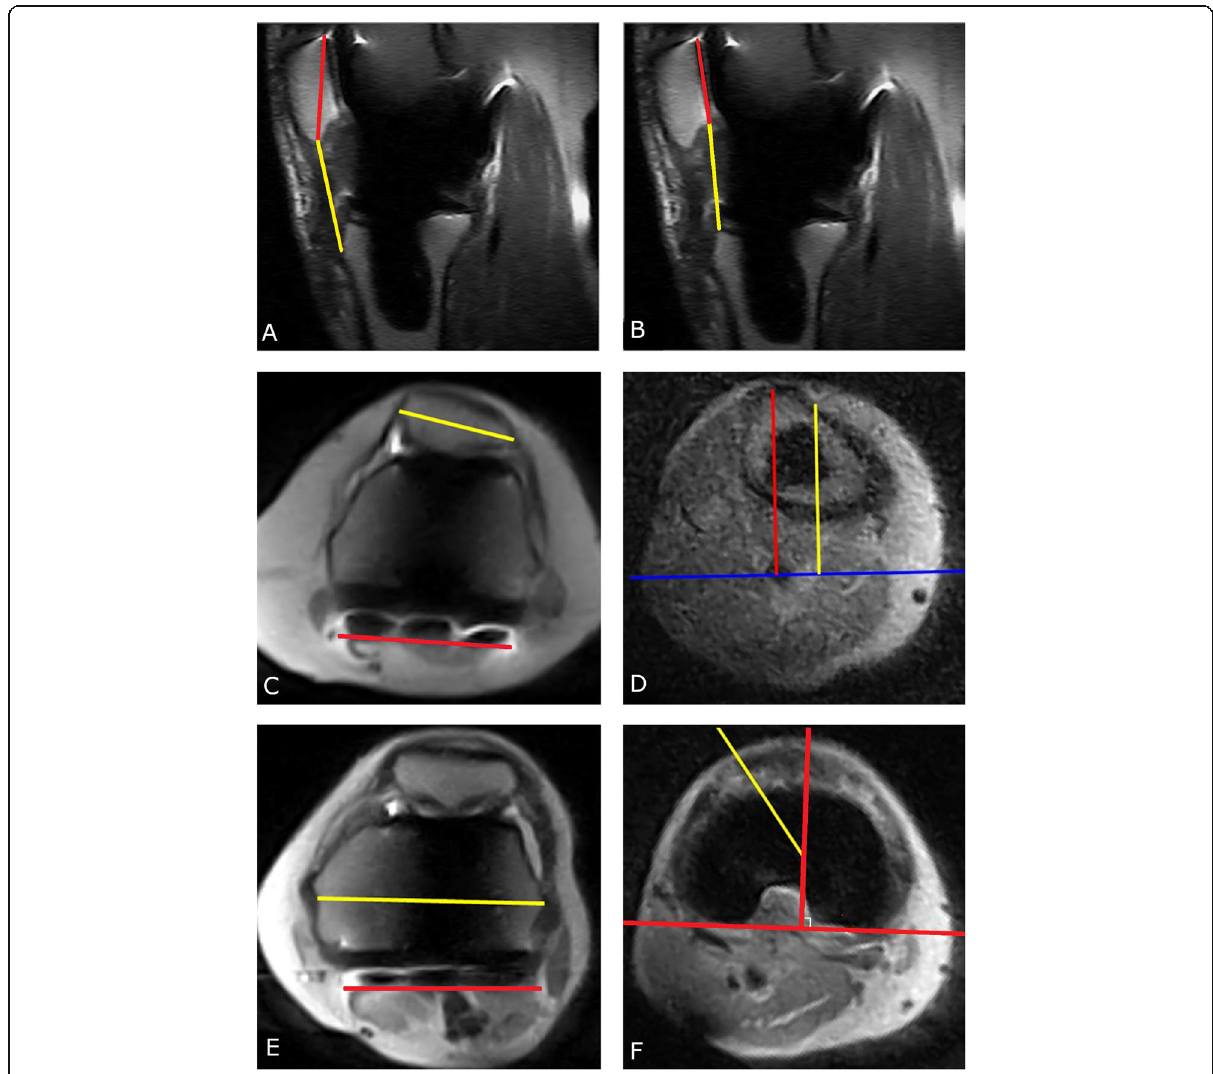
Fig. 3 Measuring patellofemoral and rotational alignment parameters. The patellar height was measured with the Insall-Salvati ratio ( a ), the length of the patellar tendon (yellow line) is divided by the diagonal length of the patella (red line), and with the Caton-Deschamps ratio ( b ), the distance between the distal pole of the patella and the tibial plateau (yellow line) is divided by the posterior length of the patella (red line). The patellar tilt angle ( c ) was measured as the angle between the maximum width of the patella (yellow line) and the posterior condylar axis (red line). The tibial tubercle- trochlear groove distance was measured on three levels, at the first level a line through the posterior epicondyle (blue) was drawn, at the second level a line through the deepest point of the trochlear groove (yellow) perpendicular to the posterior epicondyle was drawn, then on the third level a line (red) through the most anterior portion of the tibial tuberosity is drawn ( d ). The distance between the red and yellow line is the TT-TG distance. The femoral component rotation ( e ) is measured on two levels as the angle between the posterior condylar axis (red line) and the surgical transepicondylar axis (yellow line). The tibial component rotation ( f ) is measured on three levels, on the first level the centre of the tibia is determined, then on the second level the centre of the tibia is connected to the top of the tibial tuberosity (yellow line), next the angle between the yellow line and the line perpendicular on the tangent of the tibia plateau of the tibial component (red) is